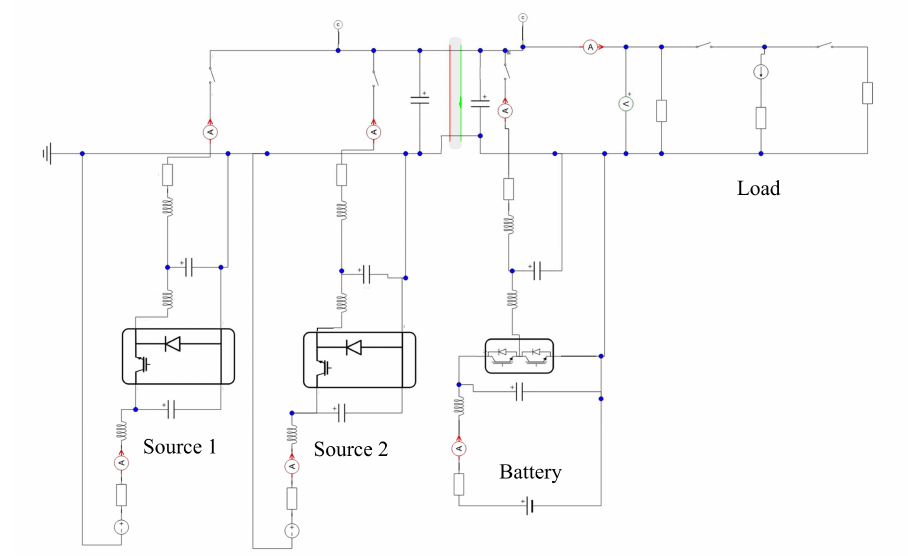
Figure 10. Hardware-in-the-loop schematic for PB microgrid example.